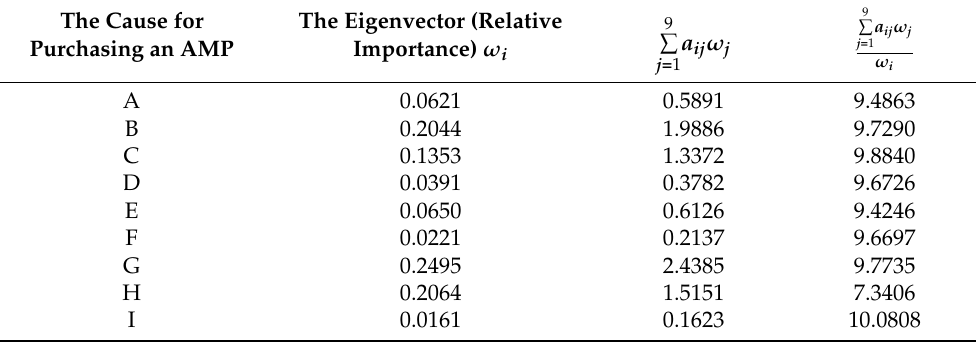
Table 6. The interim values for the calculation of the largest eigenvalue λ max